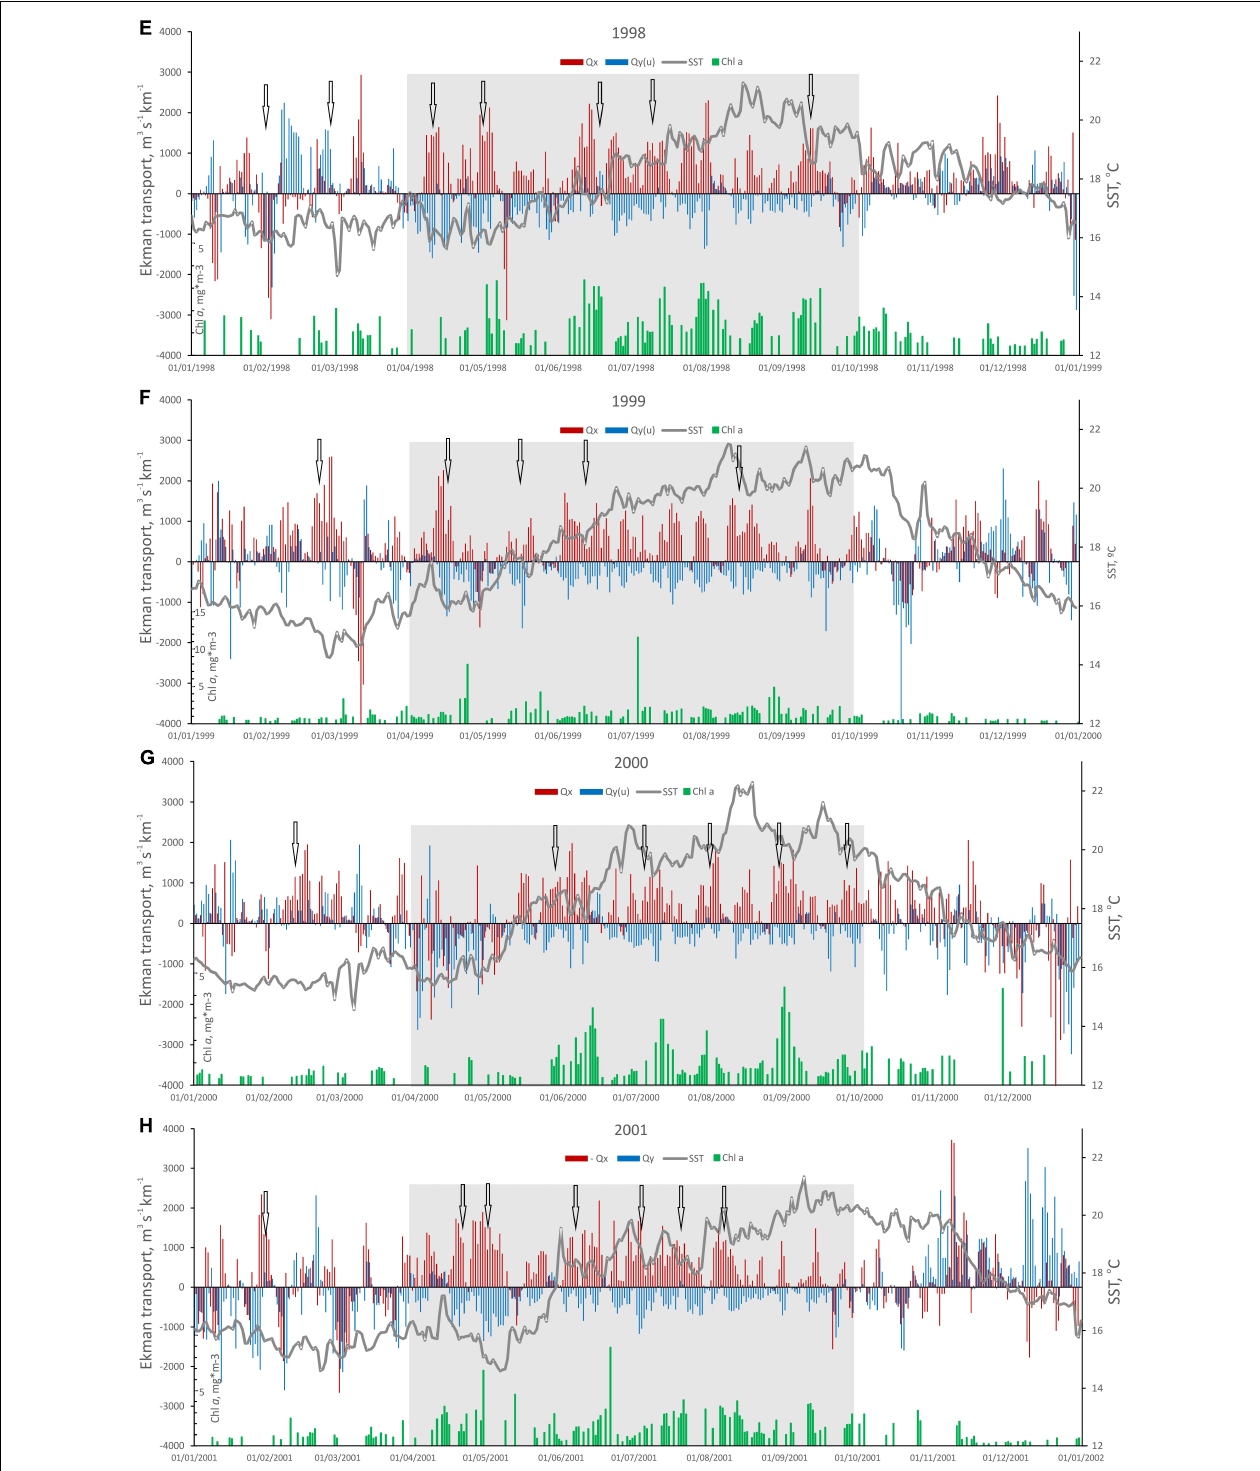
FIGURE 3 | Daily variation of eastward (-Q x ) and northward (Q y ) Ekman transport, Optimal Interpolation SST (NOAA) and Chl a (SeaWiFS) from 1994 to 2001: (A) 1994, (B) 1995, (C) 1996, (D) 1997, (E) 1998, (F) 1999, (G) 2000, and (H) 2001. Q x and Q y represent zonal and meridional upwelling indices along the western and southern coasts, respectively; Chl a SeaWiFS has data gaps. Shaded gray areas indicate main upwelling periods, arrows point at pronounced upwelling events.